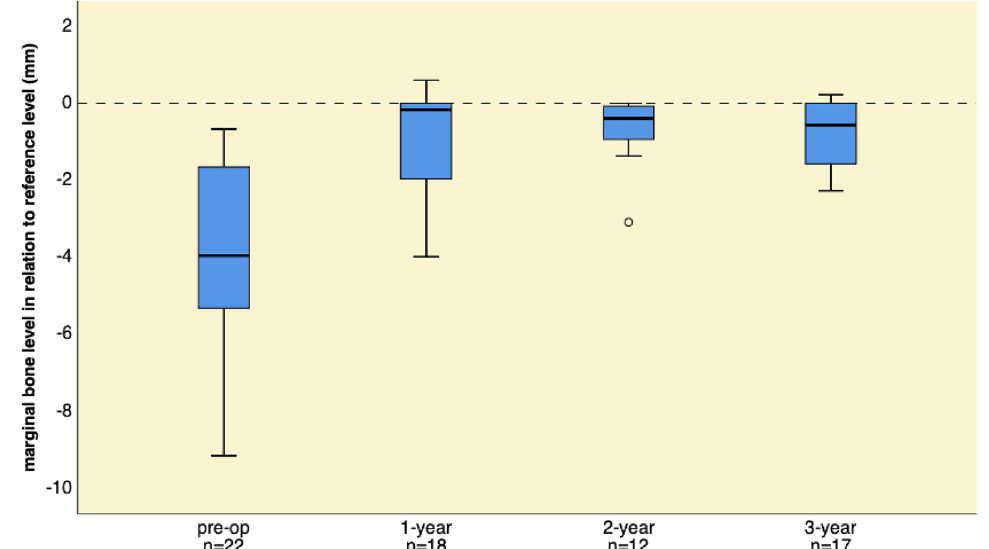
Fig. 4 Interproximal marginal bone‑level changes from pre‑operative examination to 1‑year, to 2‑year, and to 3‑year follow‑up examinations